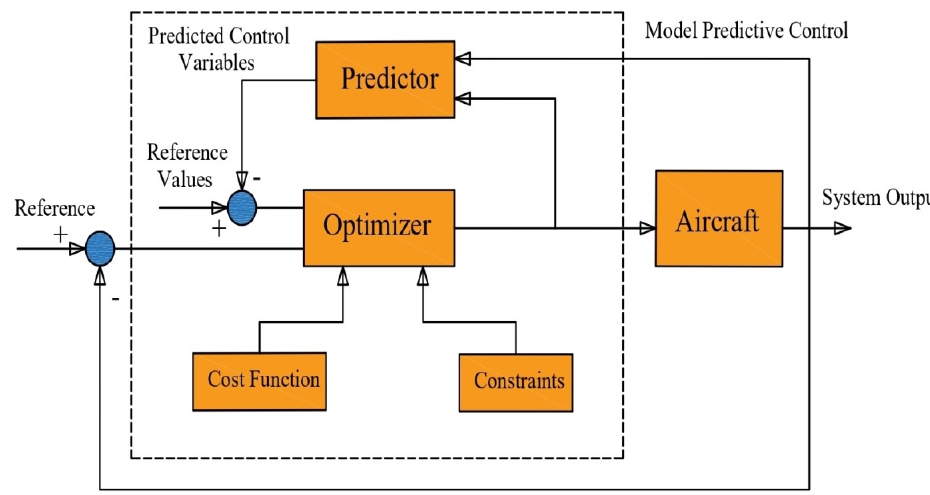
Figure 3. MPC flight control block diagram.